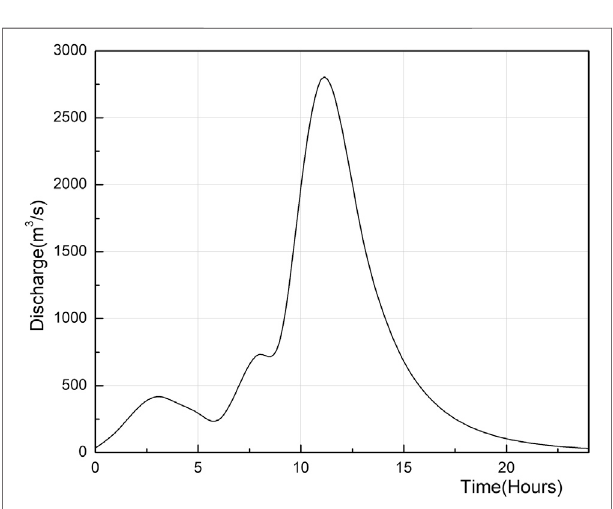
FIGURE 2 | Monitored discharge during the fl ash fl ood (near